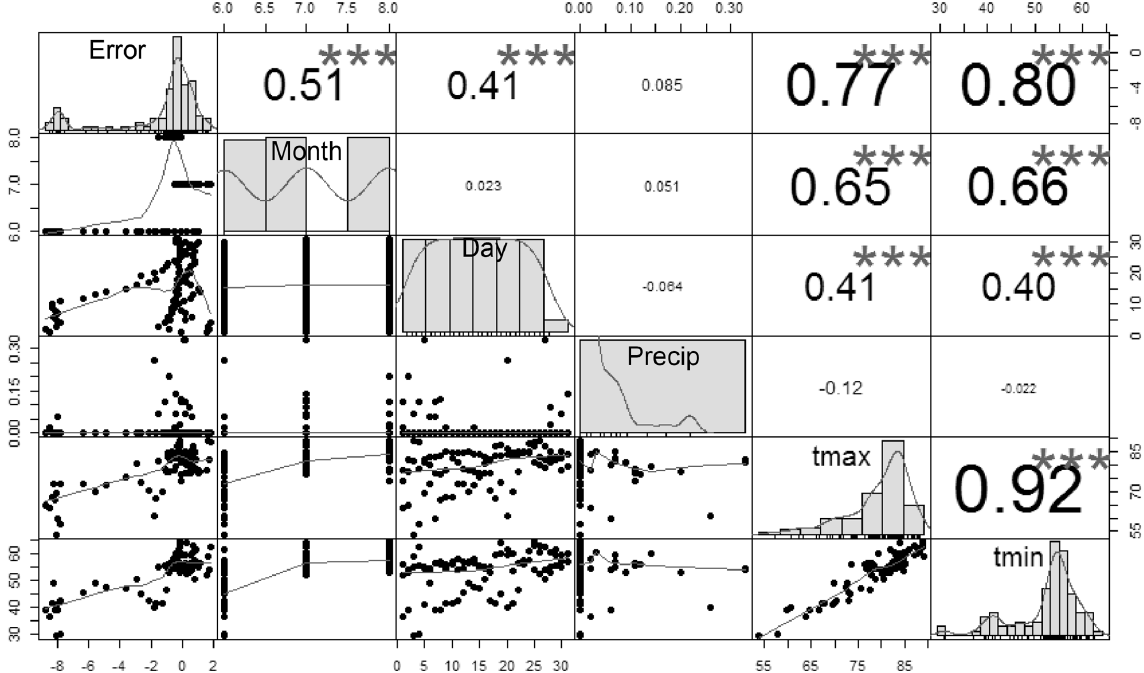
Figure 3. Correlations between PRMS inputs (i.e., precip , t max (maximum temperature), and t min (minimum temperature)) and streamflow prediction errors during May, June, July, and August (2011): the diagonal graphs show the variable distributions, the lower graphs show the scatter plots between the corresponding row and column variables, and the upper values are the correlation values between the corresponding row and column variables ( precip : precipitation; t max : maximum temperature; t min : minimum temperature); errors: streamflow prediction